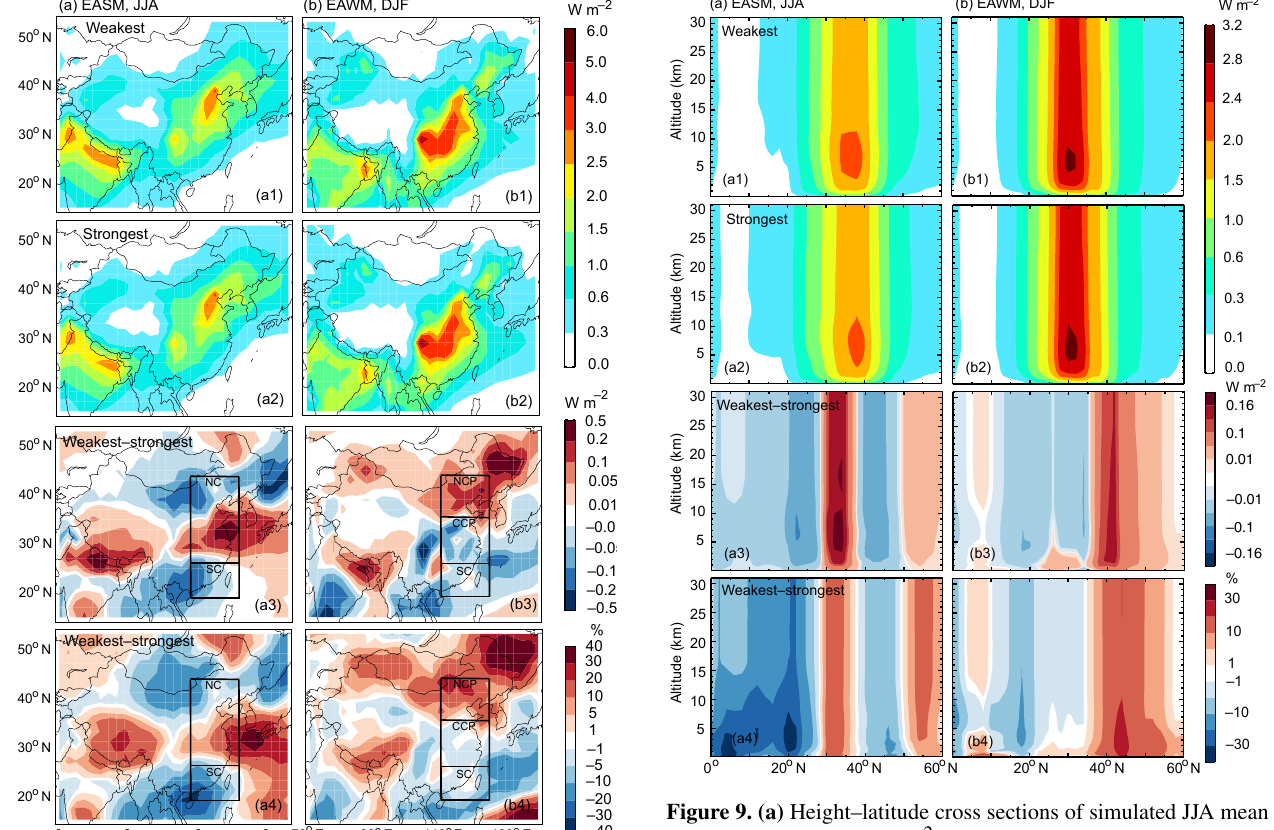
Figure 9. (a) Height–latitude cross sections of simulated JJA mean all-sky DRF of BC (Wm − 2 ) in the (a1) 5 weakest and (a2) 5 strongest EASM years during 1986–2006. Also shown are the (a3) absolute (Wm − 2 ) and (a4) percentage (%) differences be- tween the 5 weakest and 5 strongest EASM years. Plots are aver- aged over a longitude range of 110–125 ◦ E from model simulation VMET. (b) Same as (a) , but for simulated DJF mean all-sky DRF of BC in the 5 weakest and 5 strongest EAWM